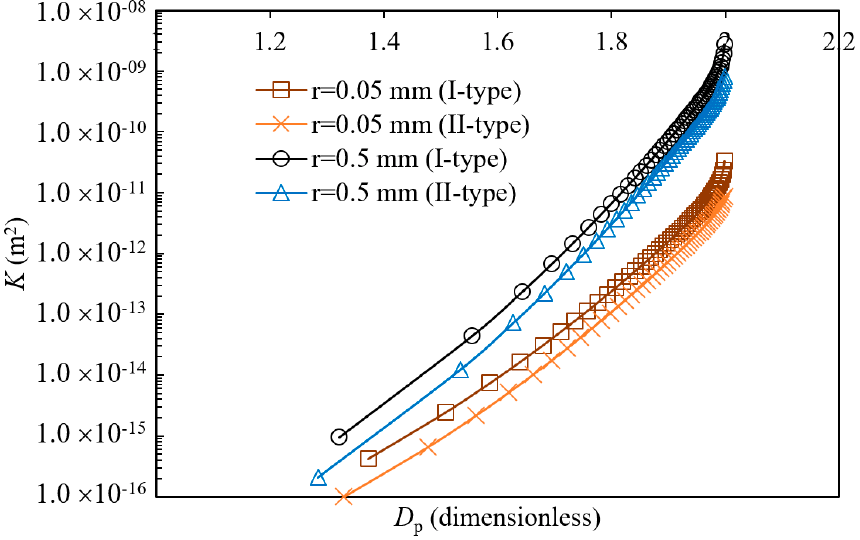
Figure 8. Effect of tortuosity fractal dimension on permeability of porous media.